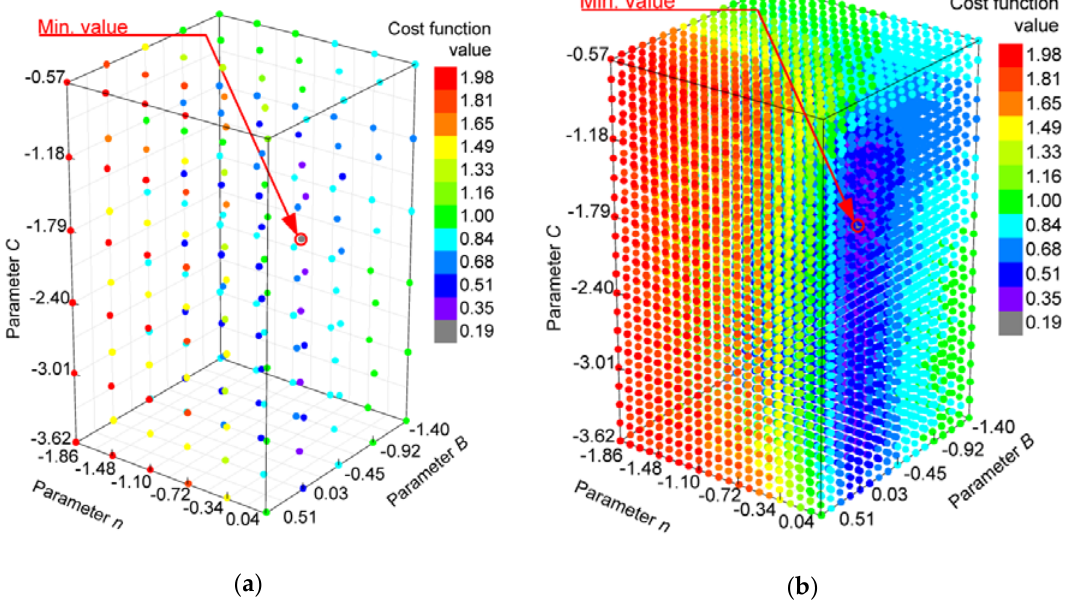
Figure 6. ( a ) Points defined by full factorial experiment (FFE); ( b ) The corresponding response surface (logarithmic values).